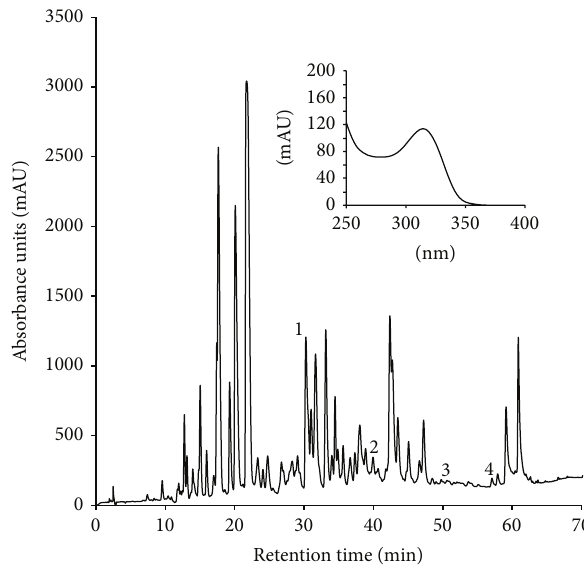
Figure1:HPLCchromatogramoflemonfruitpeelsextractacquired at 320 nm, showing the target compounds described inTable 2. 1: Cl - NCC1; 2: Cl -NCC2; 3: Cl -NCC3; 4: Cl -NCC4. Insert is the UV-vis spectrum of peak